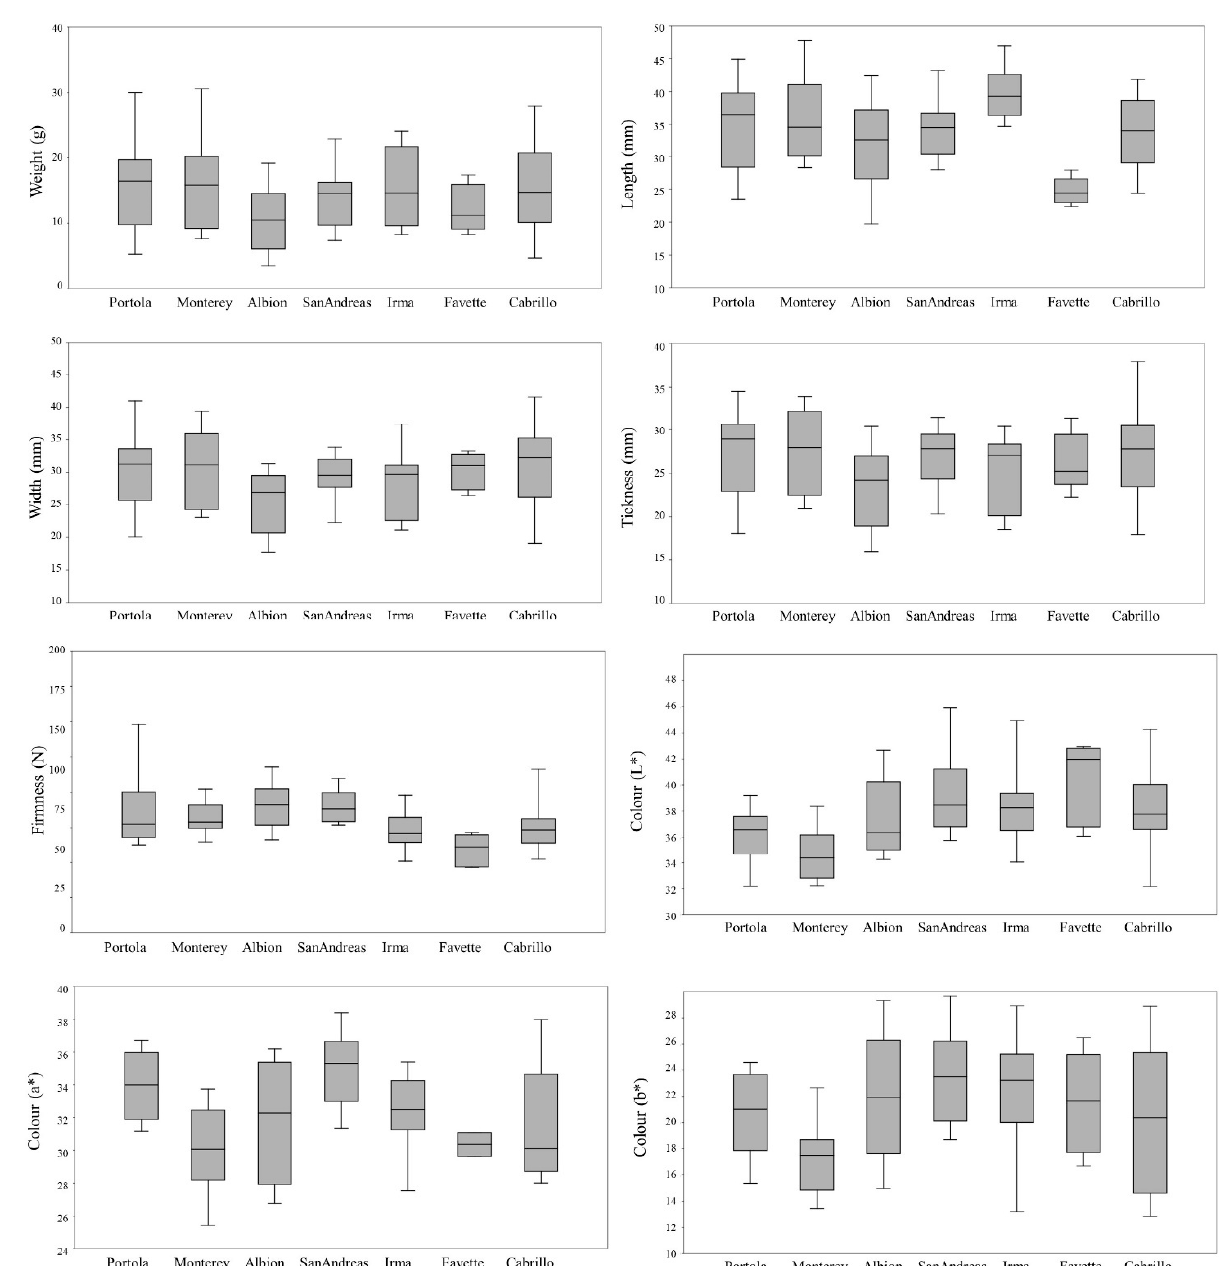
Figure 2. Dataset box plots: evaluation pomological traits variability in relation to the different cul- tivars.